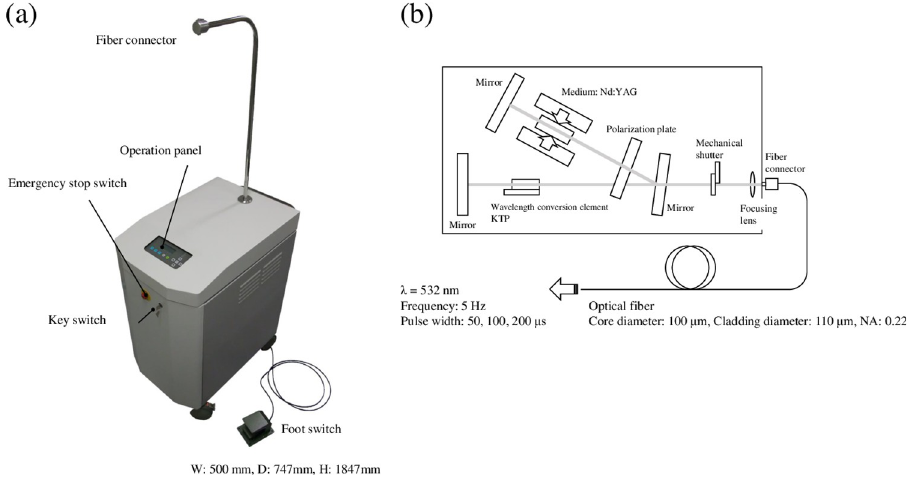
Fig 1. Laser system: LA1292. (a) External view and (b) block diagram. The transportable laser irradiation system for laser thrombolysis therapy with a doddle enclosure for preventing light leakage. Width: 500 mm, Depth: 747 mm, Height: 1847 mm (including the arm).